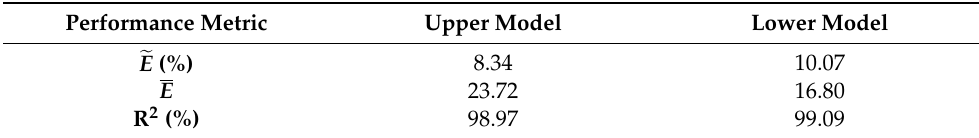
Table 5. Performance metrics of two prediction models.